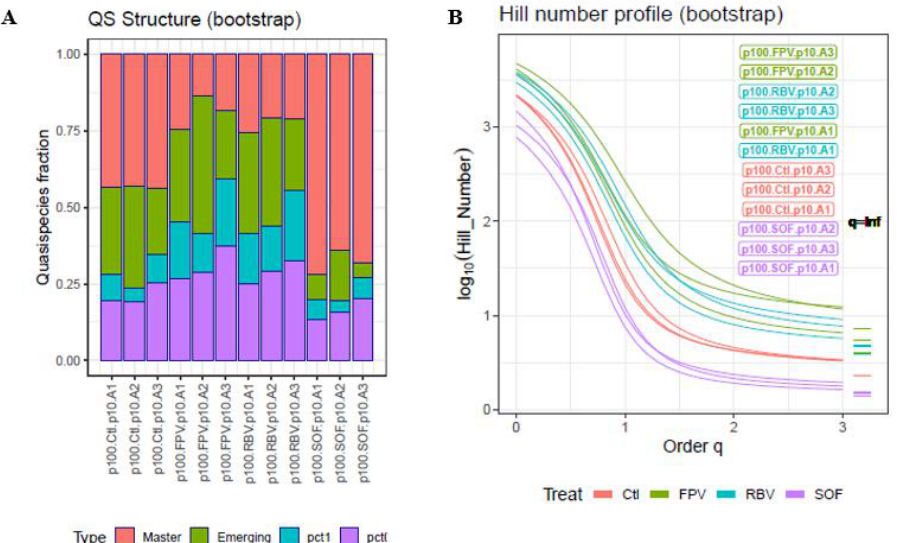
Figure 2. QFF ( A ) and HNP ( B ) plots for the HCV dataset. The labels on the right of the HNP are sorted top-down in decreasing order of Hill number at q = 2. Ctl control; FPV favipiravir; RBV ribavirin; SOF sofosbuvir. A1 to A3 refer to the amplicons analyzed. Pct1 low fitness (0.1 < Freq ≤ 1%), pct0.1 very low fitness (≤0.1%). Bootstrap values are represented. Coverage range 48,057–335,535 reads; median 206,354 reads. Table 1. Median (Interquartile range) values of each fraction by treatment condition over the three amplicons. Master Emerging RHL_1_0.1 RHL_0.1 Control